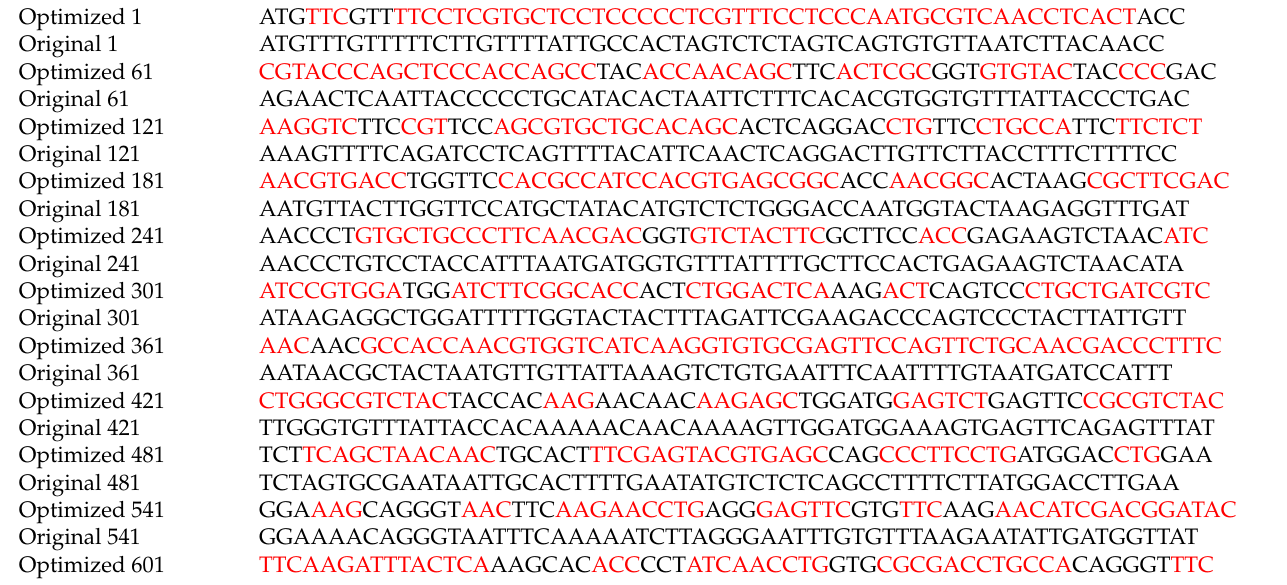
Figure 1. Transmembrane domain prediction and schematic diagram of the gene constructs. Original sequences of the S glycoprotein gene were analyzed by the TMHMM database and transmembrane protein topologies were predicted ( A ). Codon-optimized genes were constructed following the schematic illustrated above ( B ). Table 1. Codon-optimized sequences of the SARS-CoV-2 S glycoprotein, influenza HA TM-CT, and melittin signal pep- tide .